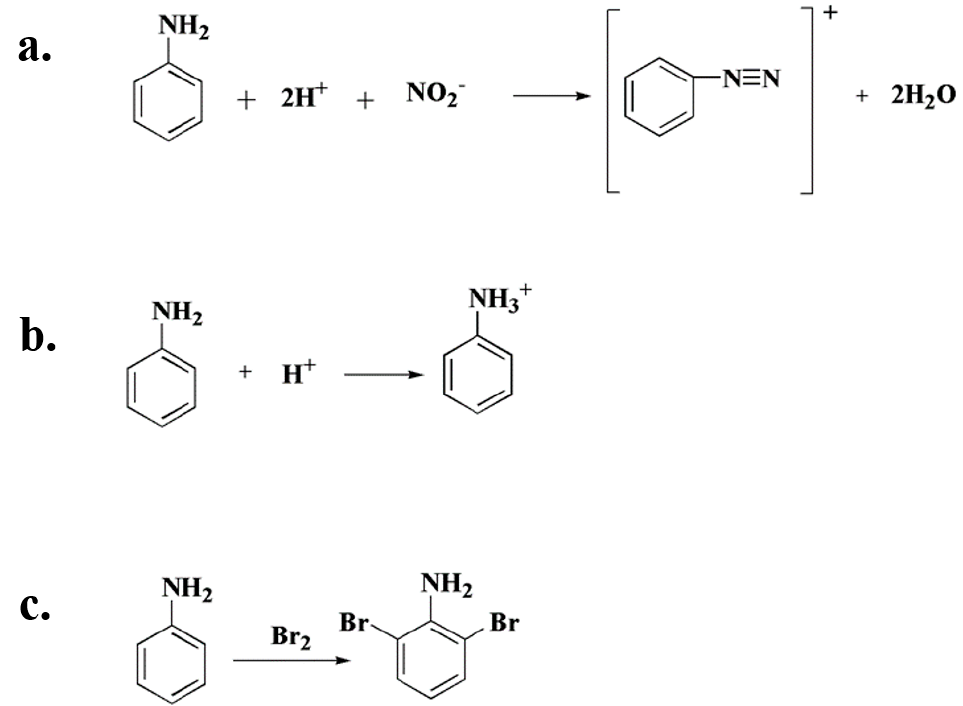
Figure 8. Possible reactions of aniline during sample pre-treatment: ( a ) aniline diazotization reaction. ( b ) aniline can generate salt under acidic conditions. ( c ) aniline undergoes halogenation reaction with halogen.